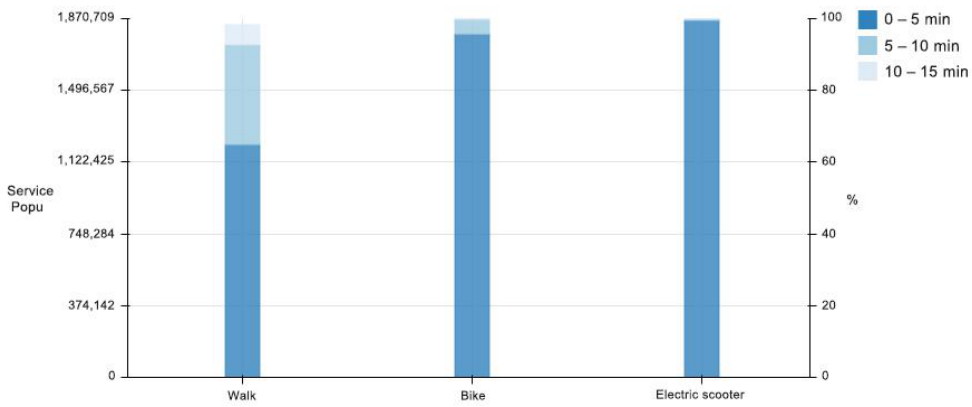
Figure 12. Service population of the community pharmacies of three travel modes.